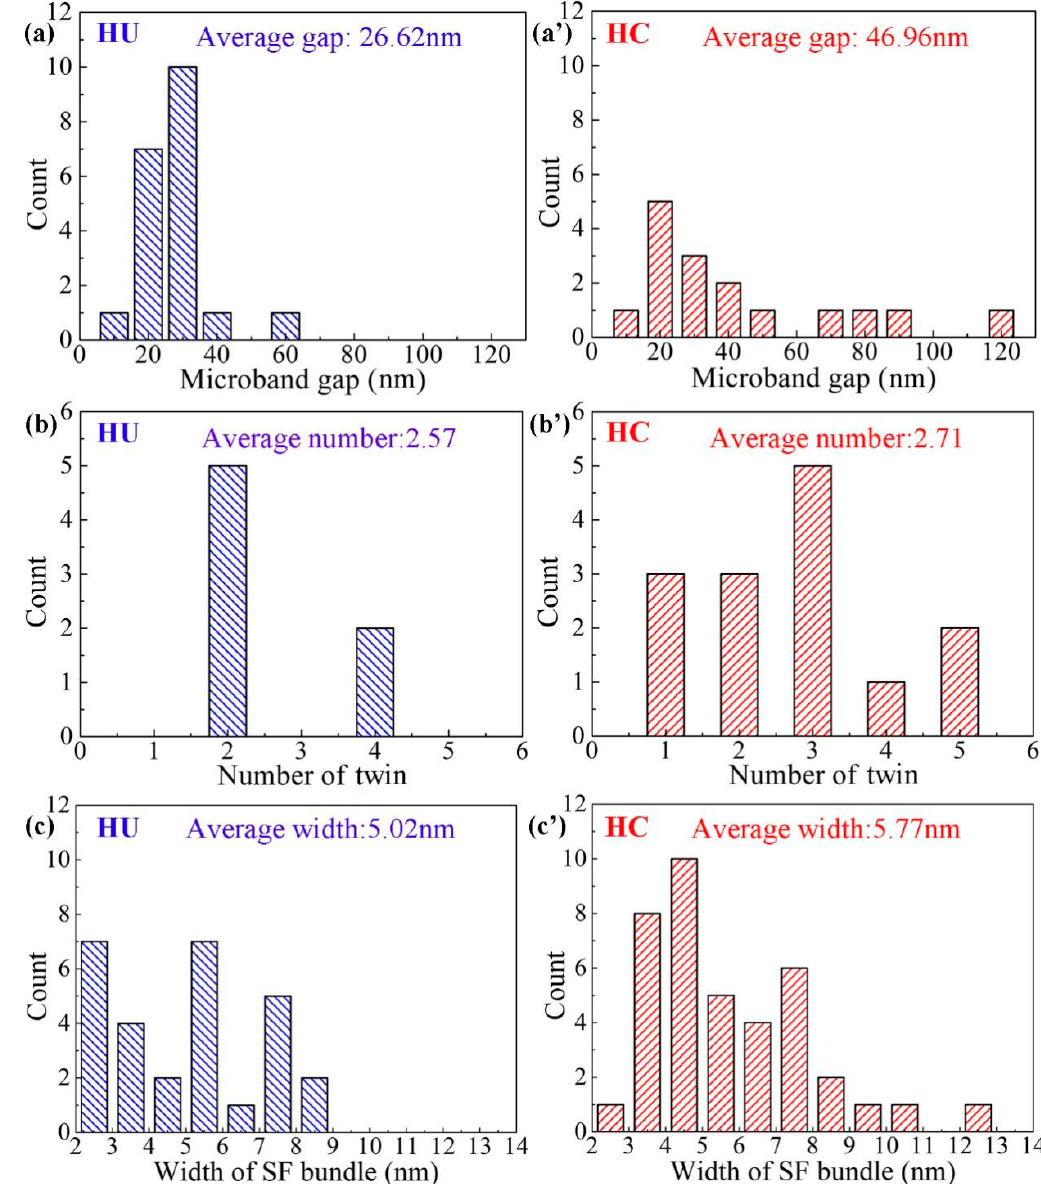
Figure 10. Statistical analysis of microband gap, number of twins, and the width of the SF bundles of hydrogen-uncharged (HU) and -charged (HC) CoCrFeMnNi alloy. ( a , a ′ ) microband gap; ( b , b ′ ) dles of hydrogen-uncharged (HU) and -charged (HC) CoCrFeMnNi alloy. ( a , a (cid:48) ) microband gap; number of twins; ( c , c ′ ) width of SF bundles. ( b , b (cid:48) ) number of twins; ( c , c (cid:48) ) width of SF